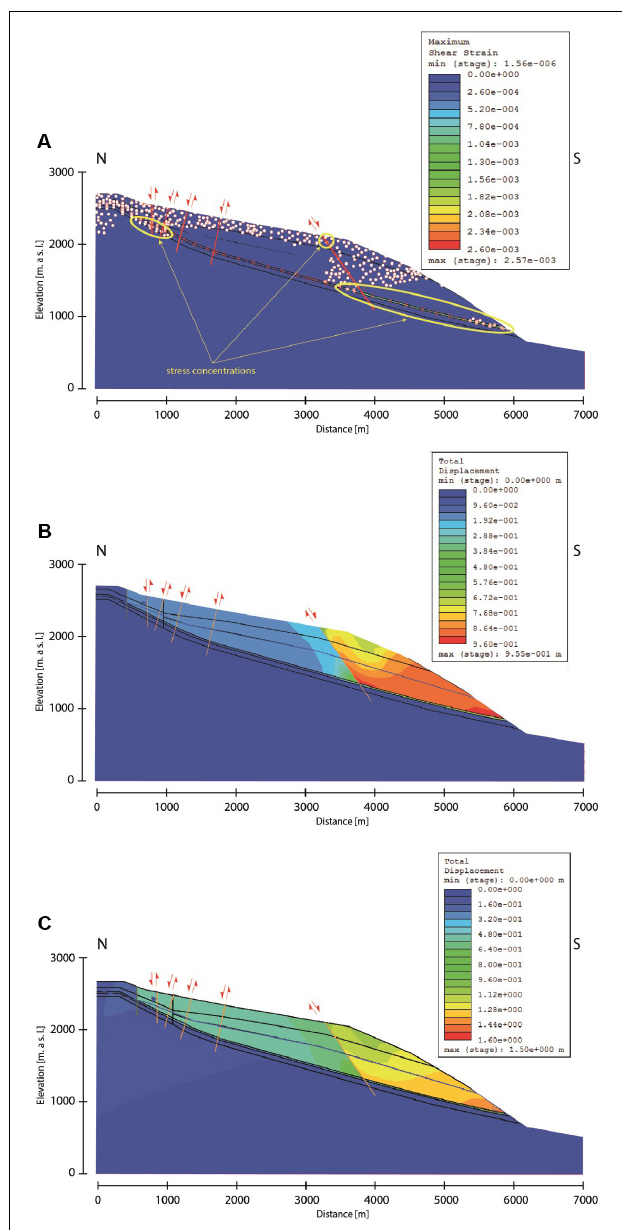
FIGURE 11 | (A) Maximum shear strain plot of simulation with secondary shear surfaces integrated as discrete planes in Phase2. The highest stress concentrations occur between the toe and the southernmost (rightmost) fault. In addition, increased strain values and tension failure occur between 500 and 1000 m distance and along the south-dipping, southernmost fault. (B) Total displacement plot for a static model, showing the importance of the southernmost fault as a compartment boundary. (C) Total displacement plot for a pseudo-static model with a seismic coefficient of